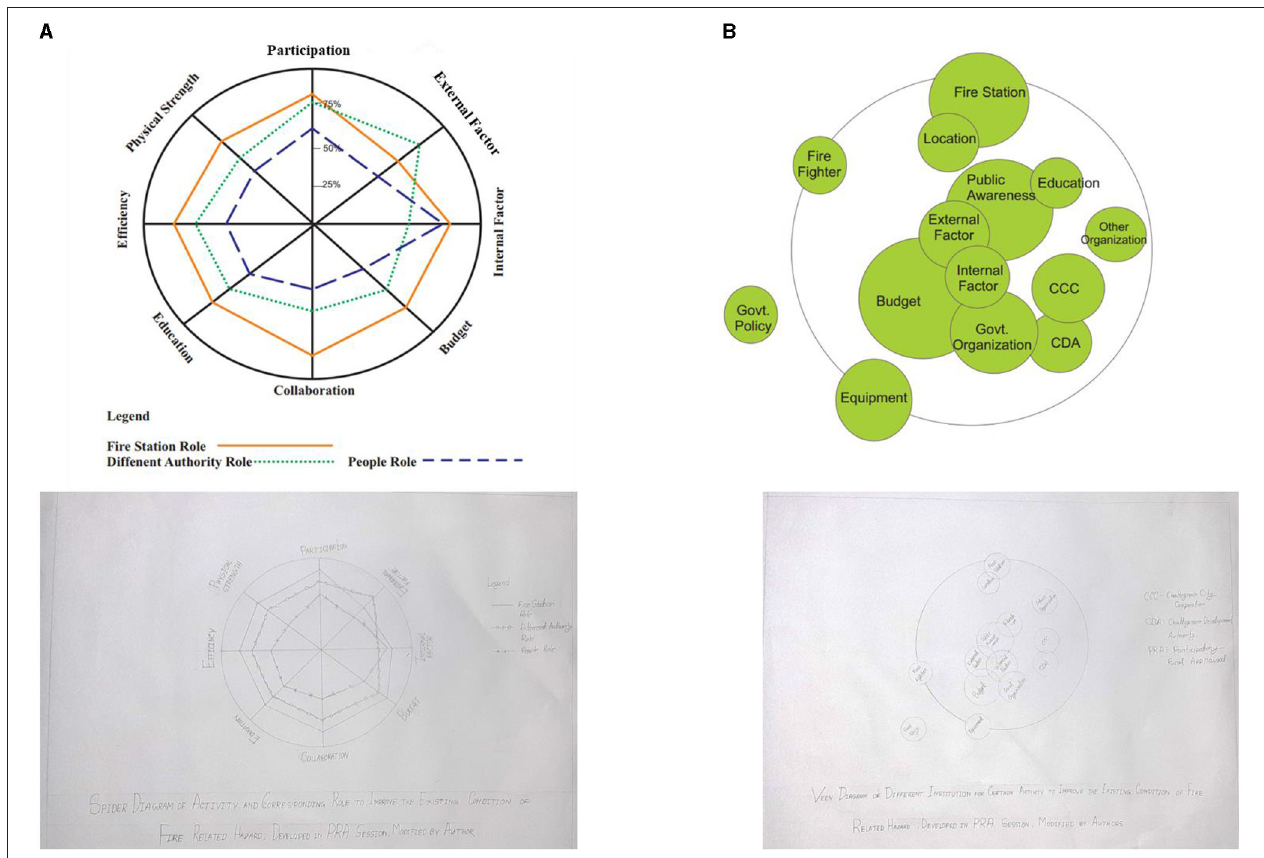
FIGURE 10 | (A) Spider diagram of activity and corresponding role to improve the existing condition of fire-related hazards, (B) Venn diagram of different institutions for certain activities to improve the existing condition of fire-related